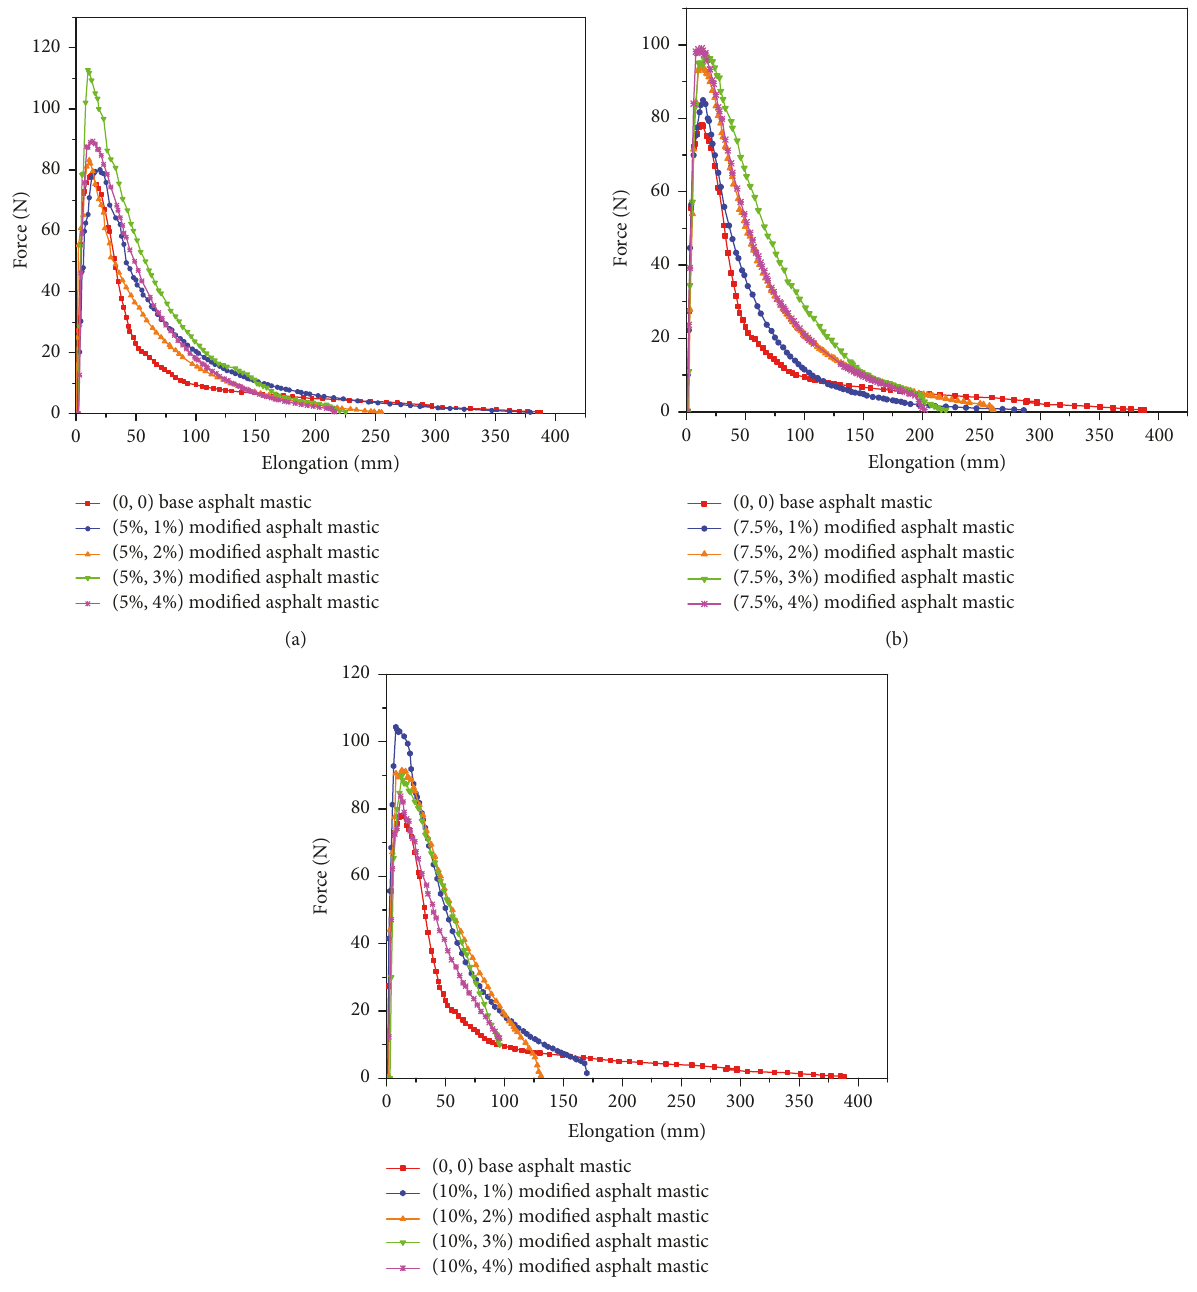
Figure 2: FDT force-elongation curves of asphalt